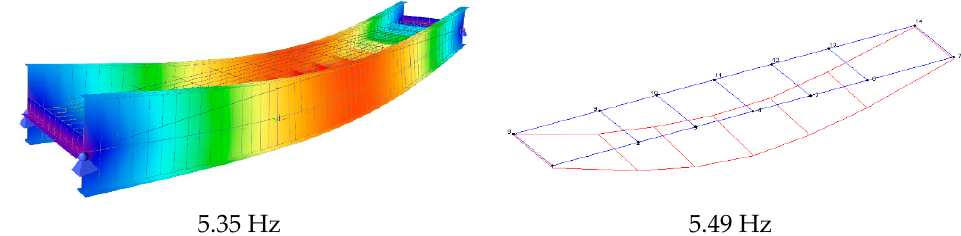
Figure 14. First modal shape and frequency computed by FEM ( left ) and determined by accel- erometers ( right ).